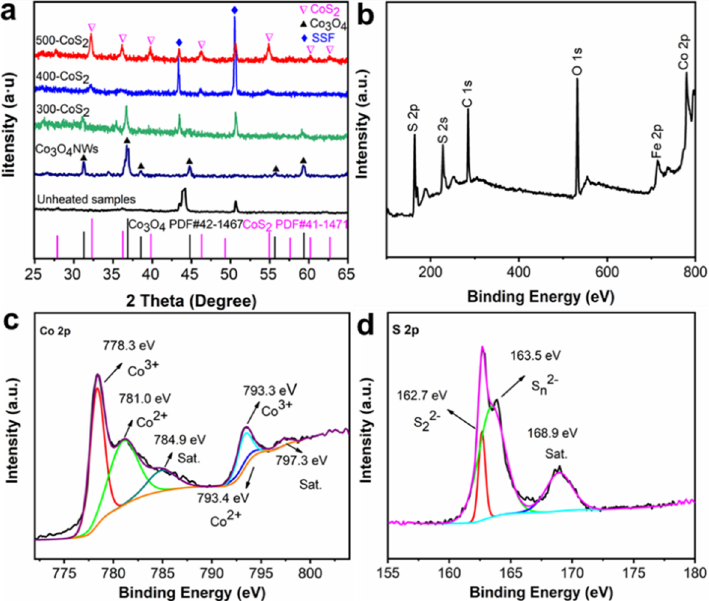
Figure 2. ( a ) The XRD diffraction pattern of the untempered by heat treatment, the Co 3 O 4 NWs samples, and CoS 2 /SSF; the XPS patterns of the CoS 2 NWs: ( b ) the total profile; ( c ) Co 2p; and ( d ) the S 2p profile. S 2p